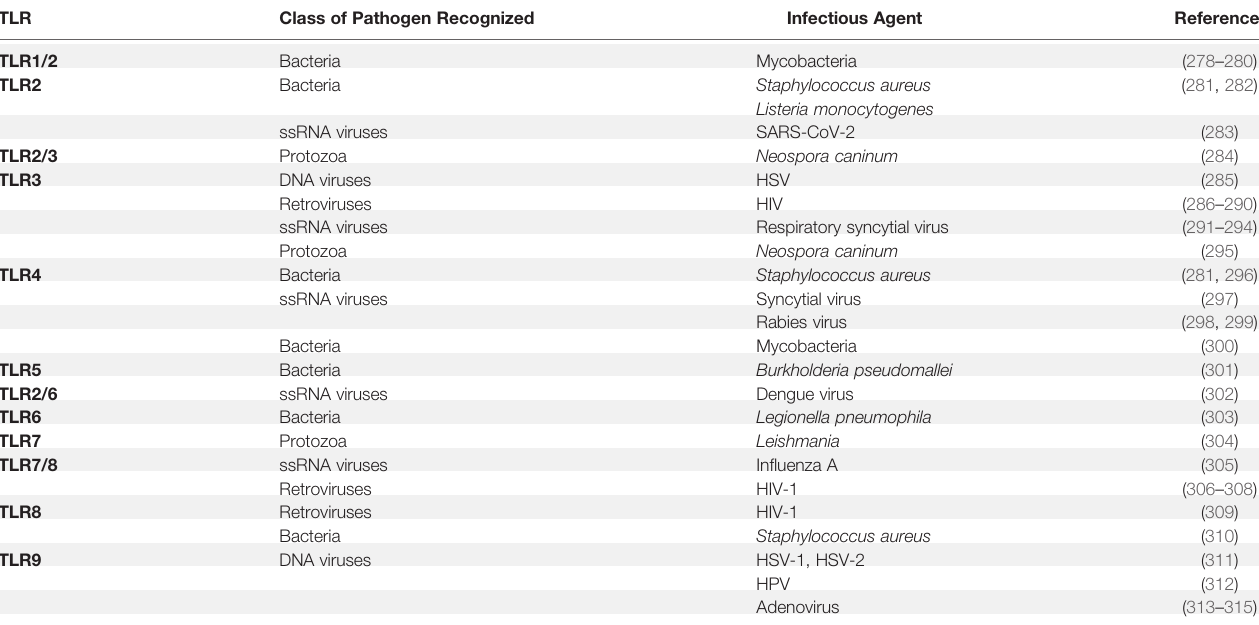
TABLE 4 | TLRs and infectious